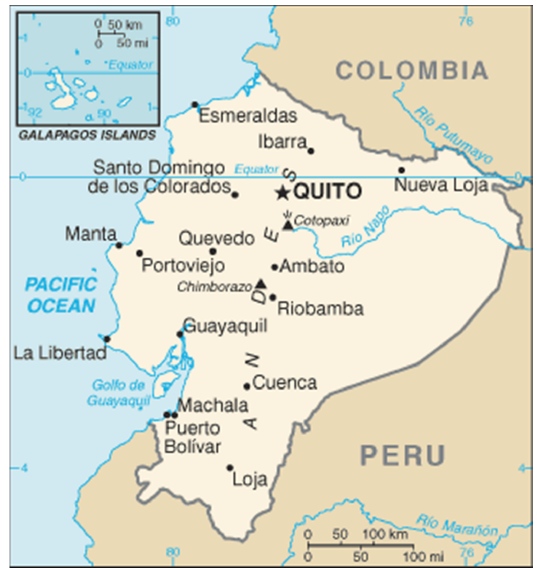
Figure 1. Map of Ecuador available online: https://www.worldometers.info/img/maps_c/EC-map.gif (accessed on 16 August 2021)